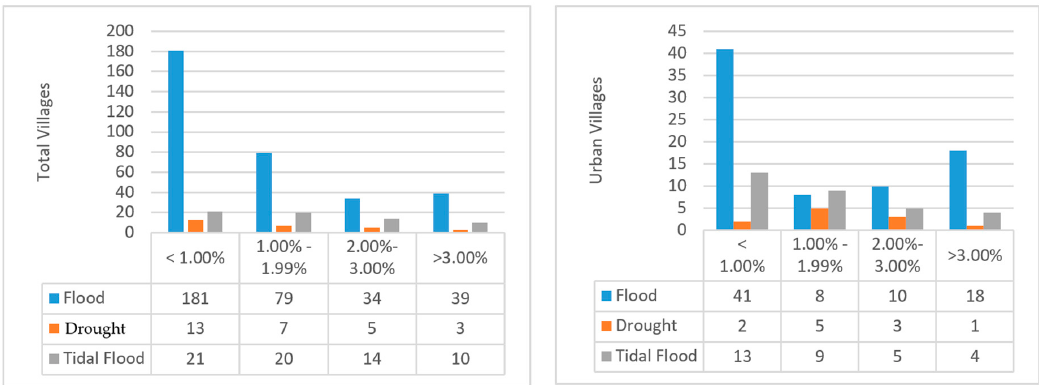
Figure 6. Distribution of different climate-related disasters within population growth rates in 2010.